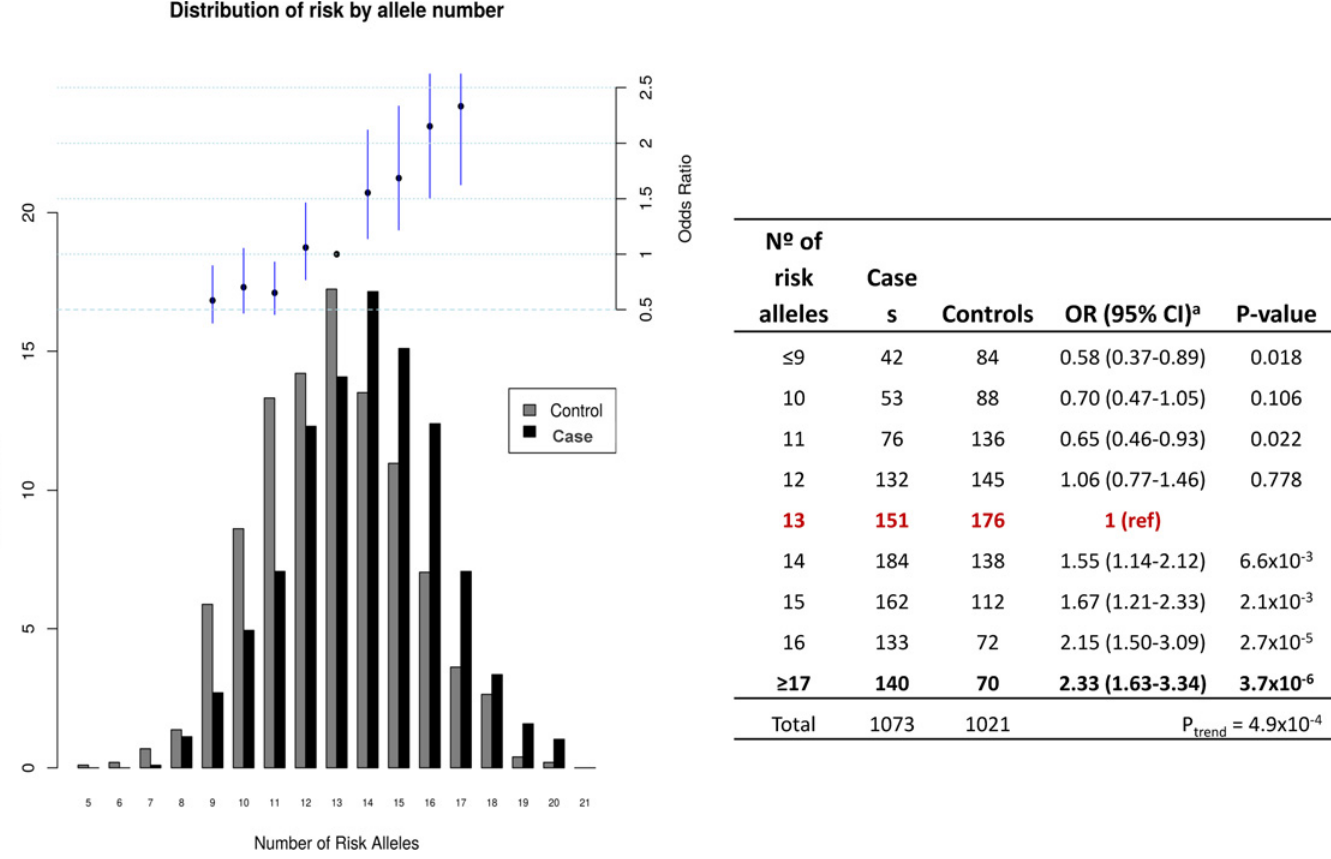
Fig 1. Cumulative impact of the 14 selected variants on adenoma risk. Distribution of risk alleles for cases (black bars) and controls (grey bars). Upper panel and table: Plot of the ORs for cases with increasing number of risk alleles. ORs are relative to the median number of risk alleles in controls (13 risk alleles as reference group). Vertical bars correspond to 95% CI. Statistical significance is shown in the table for the different groups of multiple risk